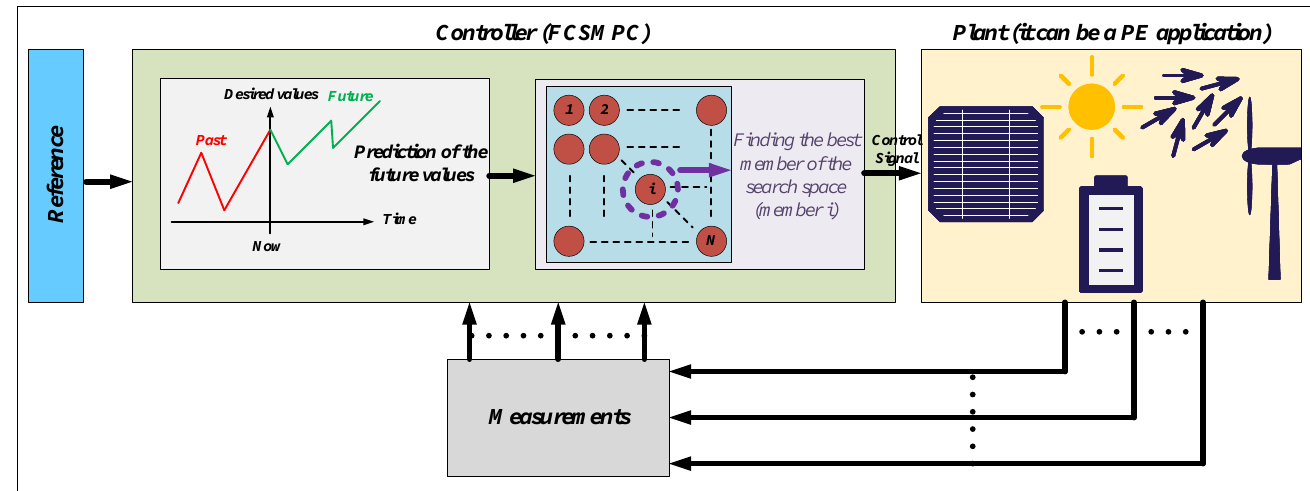
Figure 5. Implementation of FCSMPSC in PE